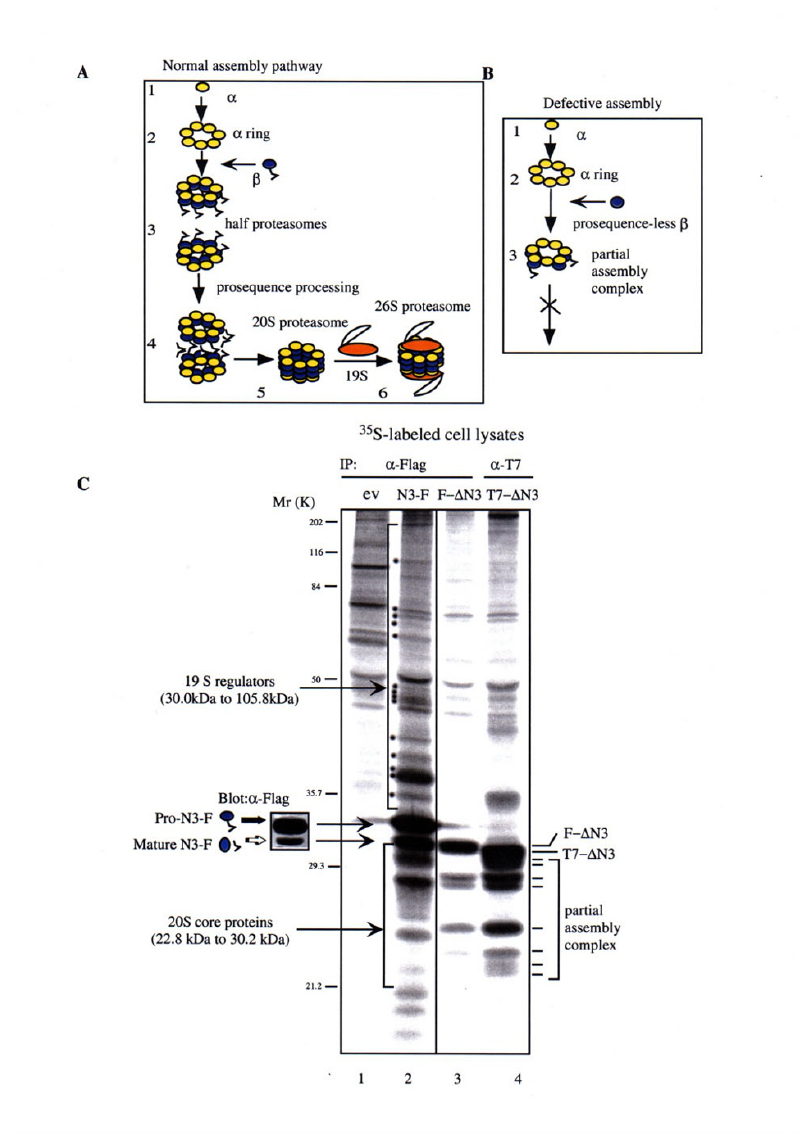
Figure 2 The expression and assembly of HsN3 in transfected COS1 cells.A. A cartoon that illustrates the multiple steps known to involve in the assembly of the 26S proteasome. See text for details. B. A cartoon that illustrate the importance of β subunit prosequence in proteasome assembly. See text for details. C. The different assembly properties of wild type HsN3 and mutant HsN3 lacking its prosequence in transfected COS1 cells. COS1 was transfected with N3-F, a construct that contains the full-length wild type HsN3 and a Flag-epitope at the C-terminus (lane 2), or with F- ∆ N3 (lane 3), a construct that lacks its prosequence at the N-terminus, instead contains an N-terminal Flag-epitope, or with T7- ∆ N3, a construct that similarly lacks the prosequence but contains an N-terminal T7-epitope (lane 4). Cells were metabolically labeled with 35 S-methionine for 4 hrs before cells were harvested and analyzed by immunoprecipitation, as indicated. The two major bands in lane 2 were detected by Western blot using anti-Flag and marked out as prosequence-containing HsN3 (Pro-N3-F) and mature HsN3 (mature N3-F). The endogenous proteasome components at the molecular weight range of 19S proteasome (marked by small dots) or 20S proteasome in lane 2 are marked with brackets. A distinct set of eight bands that commonly detected to be asso- ciated with F- ∆ N3 or T7- ∆ N3 is marked with short lines at the right side of the panel. The transfection efficiency was moni- tored by co-transfection with a GFP construct. Equal transfection efficiency (70–80%) among different samples in a single experiment was the pre-requisite for metabolic labeling and the subsequent immunoprecipitation assays. Equal total amount of proteins were used for